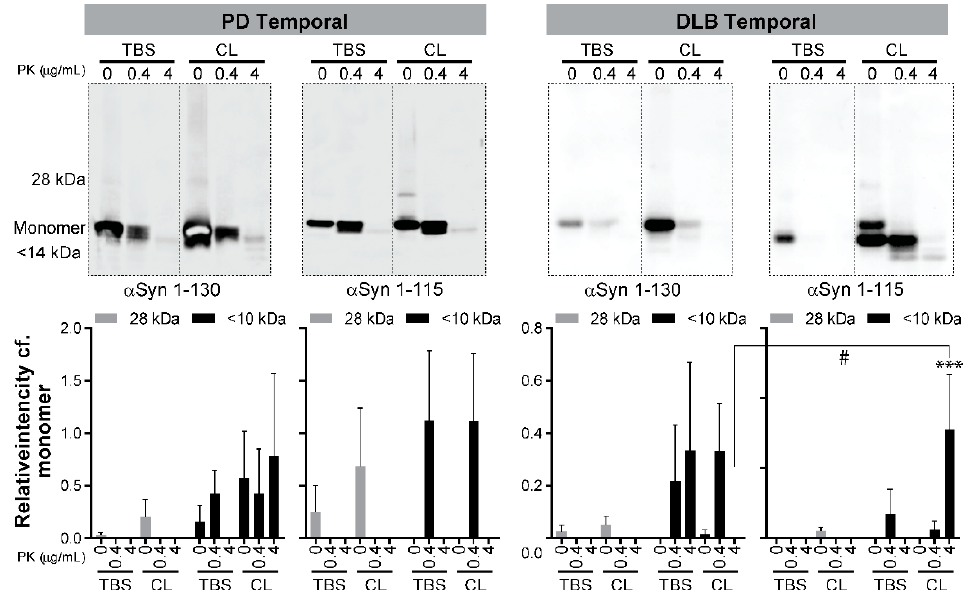
Figure 5. PK digestion of RT-QuIC end products from the temporal cortex of PD and DLB cases. The RT-QuIC end products (as described in Figures 2 and 3) were collected and incubated at 37 ◦ C with increasing concentrations of PK (0, 0.4, 4 µ g/mL). The figure shows two panels where in each panel a representative immunoblot is shown for RT-QuIC PK digestion reactions, and a bar graph summarizing immunoblot quantification from three cases for each condition. Immunoblots were quantified using ImageJ to calculate the intensity of aggregates (28 kDa) and PK-digested products (<14 kDa) relative to the intensity of the monomeric α Syn in each lane. Statistical analysis was performed with GraphPad Prism using two-way ANOVA with Tukey’s post-test. Asterisks denote significant differences within a condition (*** p < 0.001) and hashtags denote differences across groups (# p < 0.05). Higher exposures of the blots are shown in Supplementary Figure S3 to show the high-molecular weight bands corresponding to α Syn aggregation.